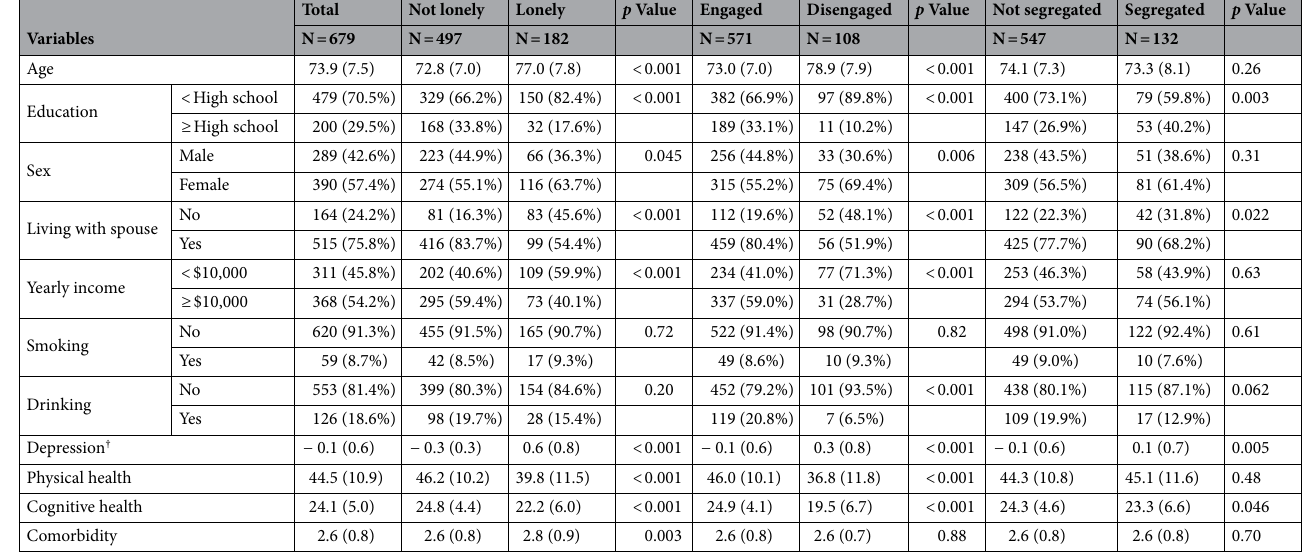
Table 1. Characteristics of the sample stratified by levels of loneliness, social disengagement, and group- level segregation at the censor/failure time (N = 679). Numbers represent the mean (standard deviation) for continuous measures and cell frequency (column %) for binary measures. † The CES-D score for depression was